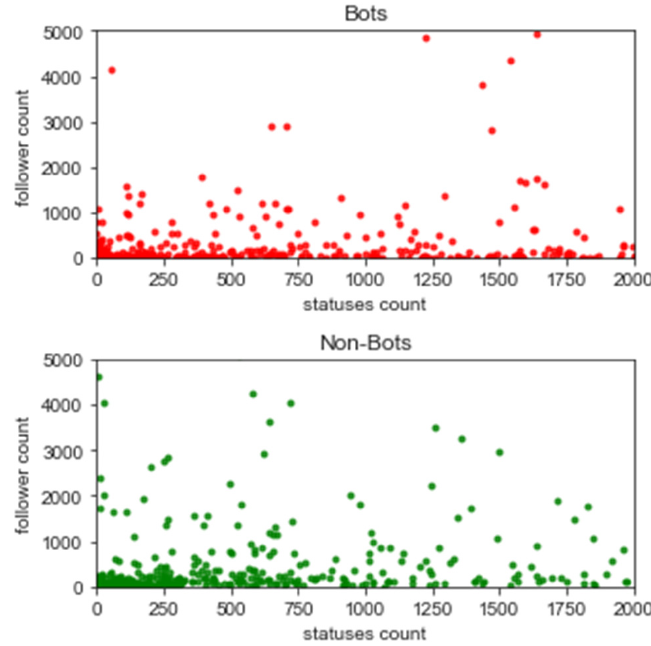
Figure 10. Follower count against statuses count for Bots and Non-bots.